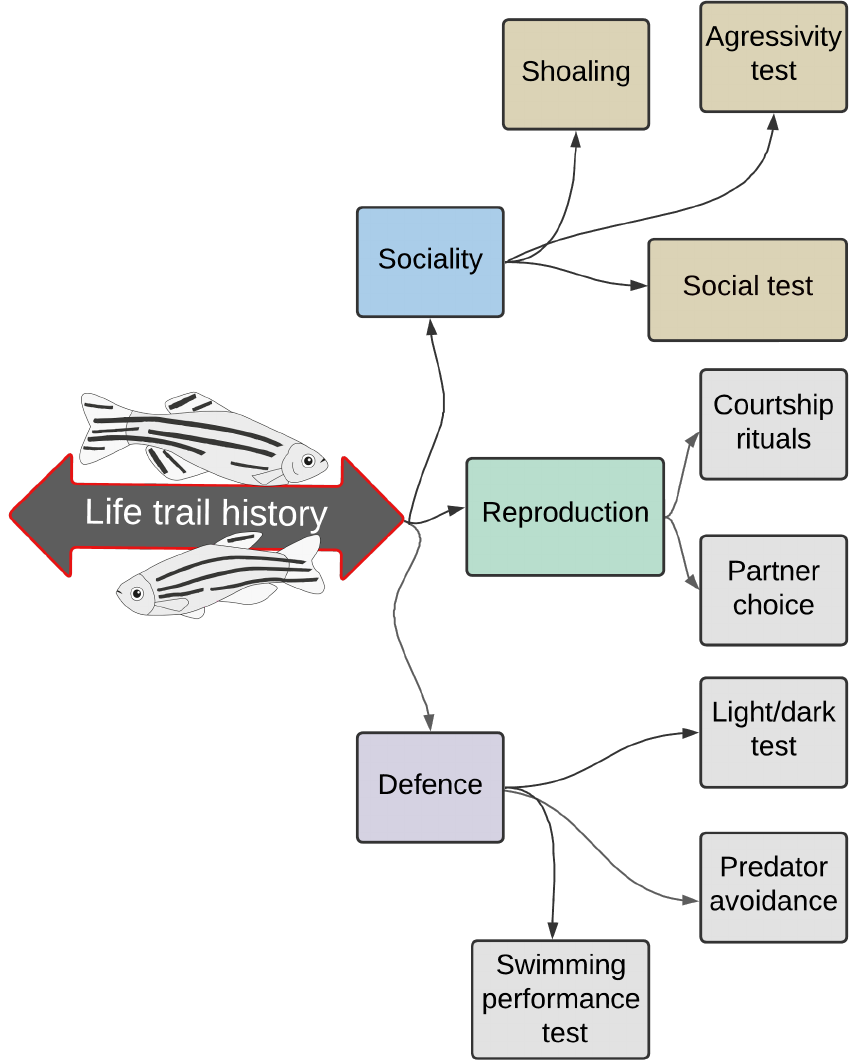
Figure 1. Laboratory experiments with different tests can provide essential information about toxicants’ impact on one or more behavioural domains in zebrafish (sociality, reproduction, defence), which are likely to affect these complex responses. The particular facts are related to the responses received at the population, species, community, and ecosystem levels (data modified from Dutra Costa et al. [11]).